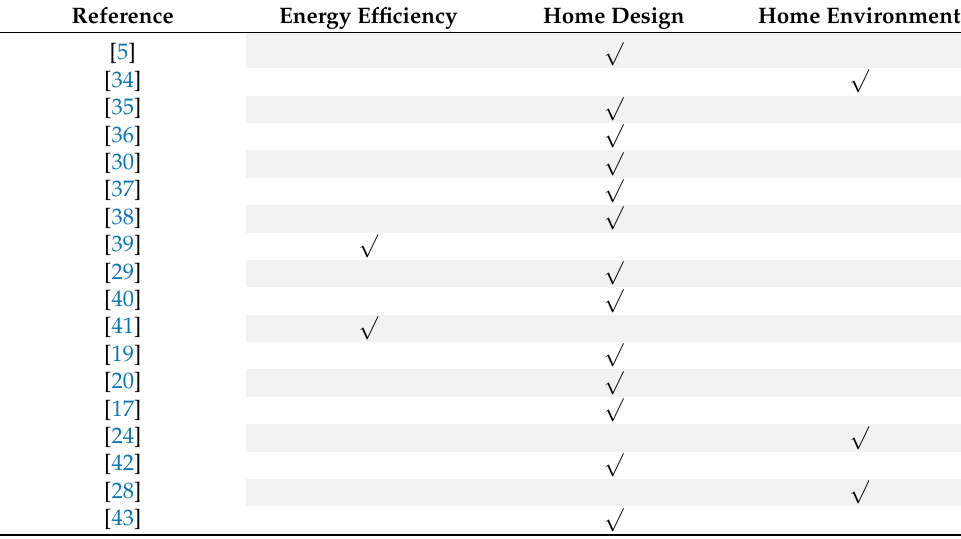
Table 4. Authors according to the